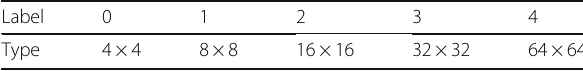
Table 1 Labels for the TU partition types